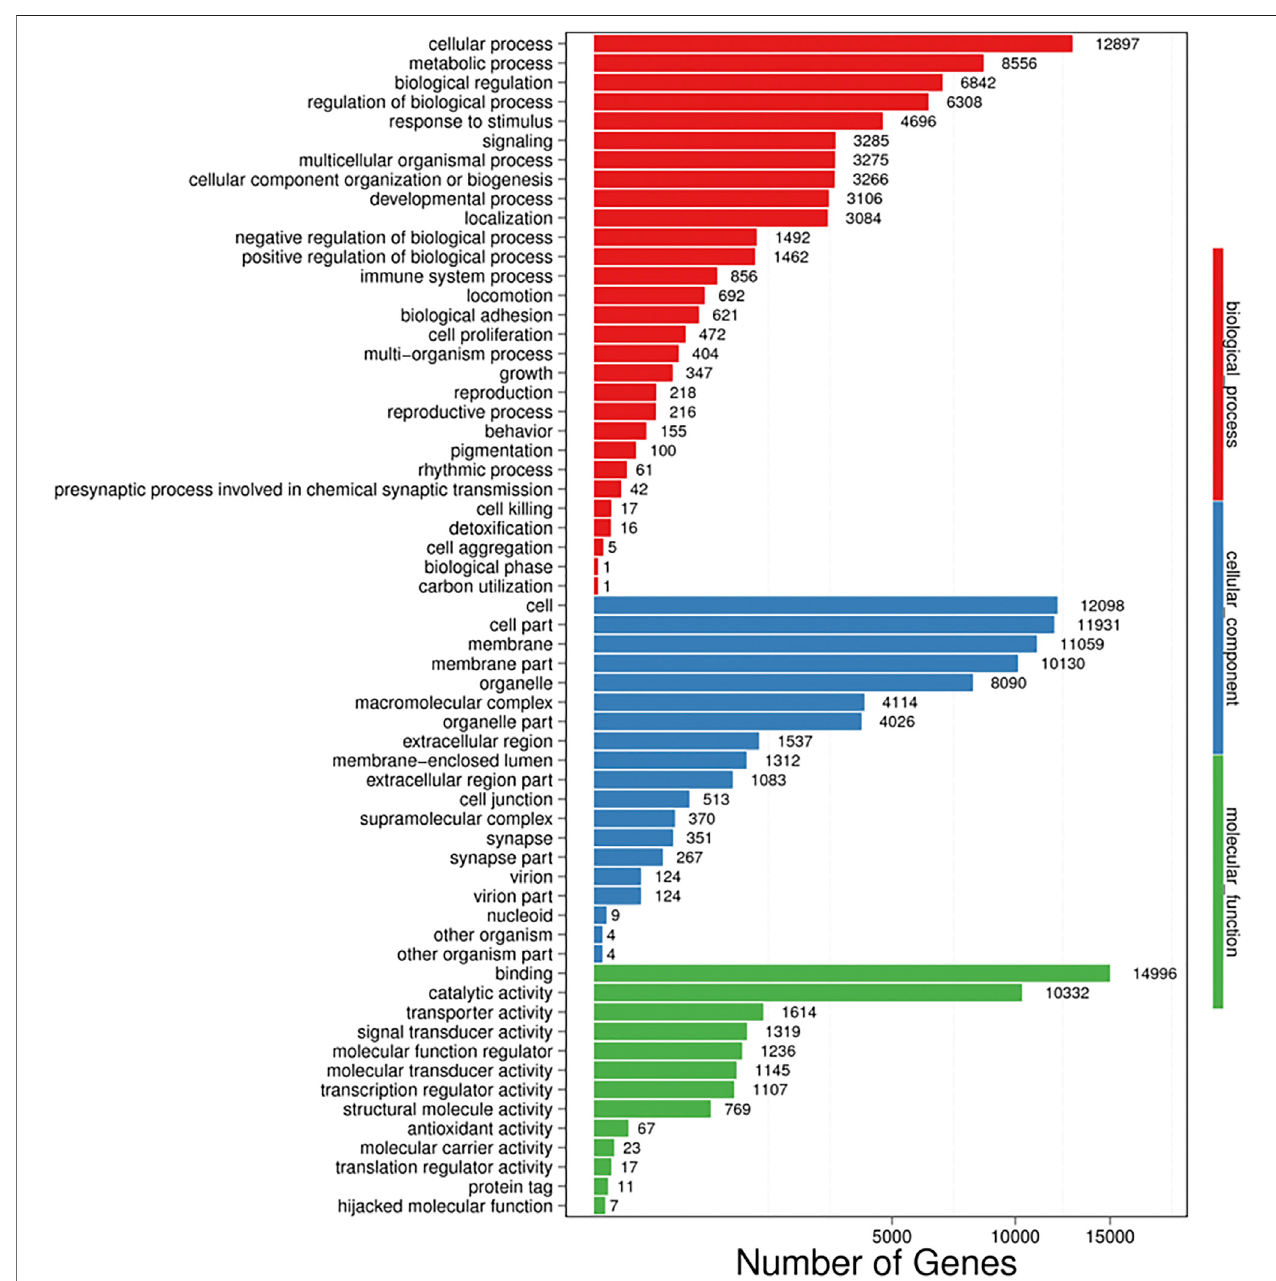
FIGURE 2 | Gene ontology (GO) analysis of all unigenes identi fi ed by the transcriptome analysis. The left y -axis indicates the percentage of a speci fi c category of proteins existed in the main category, whereas the right y -axis indicates the number of a speci fi c category of proteins existed in main category. The matched unigenes were divided into three categories, including biological process (62,493), cellular component (67,146), and molecular function (32,643). The matched unigenes were comprisedof61functionalgroups,inwhichthenumberofunigenesineach functionalgrouprangedfrom1to14,996.Binding;Cellularprocess,Cell,Cellpartand membrane represent the top fi ve functional